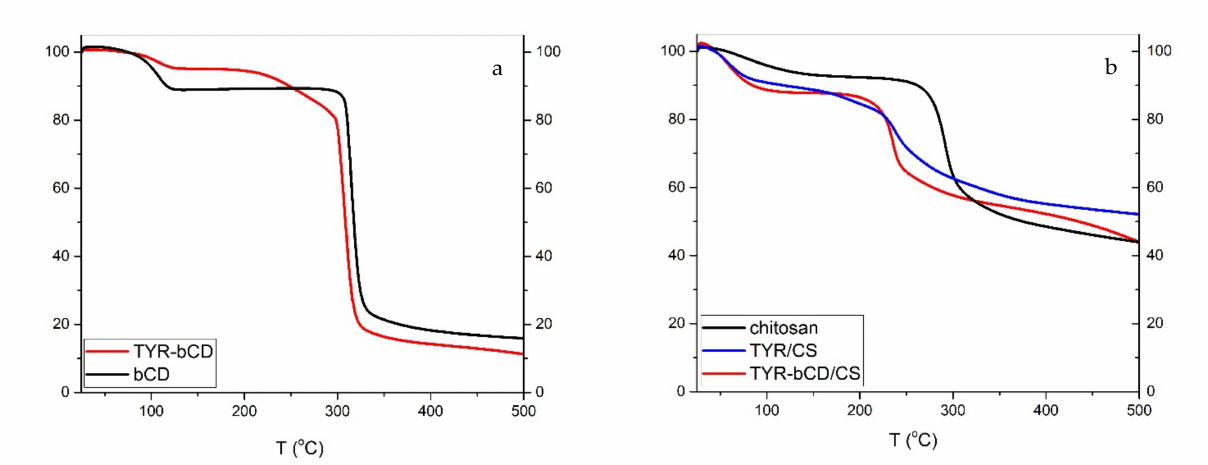
Figure 11. TGA thermograms of ( a ) β -cyclodextrin and TYR- β CD and ( b ) chitosan, TYR/CS and TYR- β